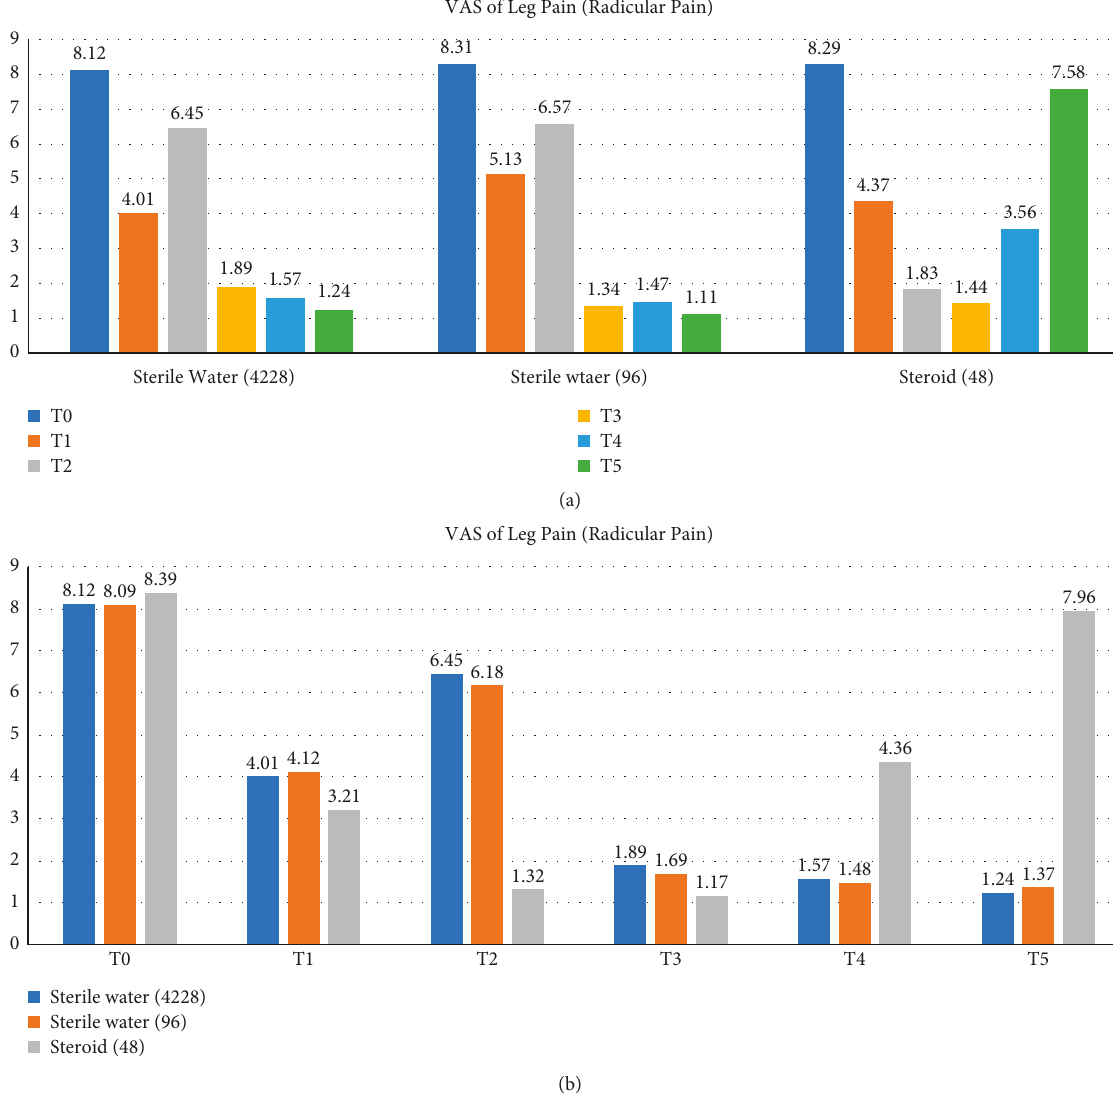
Figure 3: The comparison within group (a) and between groups (b) of VAS for leg pain (radicular pain) at 6 time points as preinjection (T0), immediately (T1), one week (T2), 1 month (T3), 3 months (T4), and 6 months (T5) after